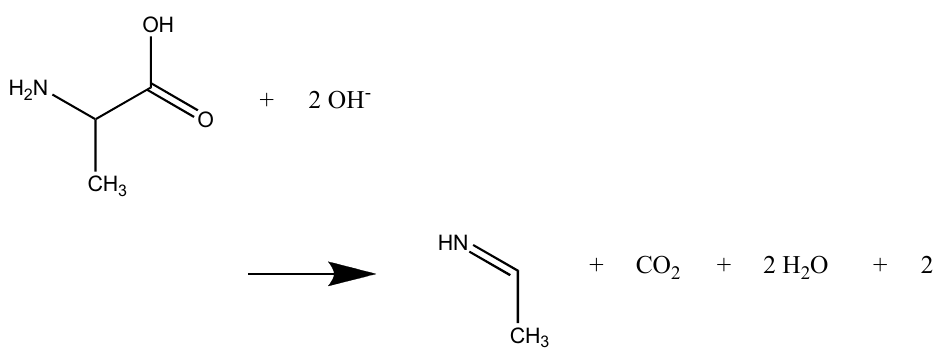
Figure 4. Net reaction of two alanine zwitterions as observed in the simulations.